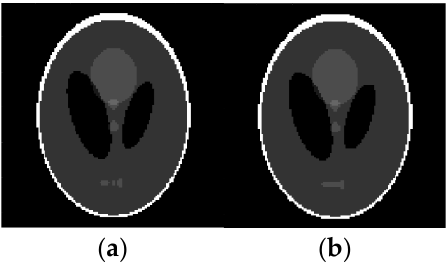
Figure 8. Reconstruction of Shepp-Logan image based on qualitative data. ( a ) Original image; ( b ) Reconstructed image.